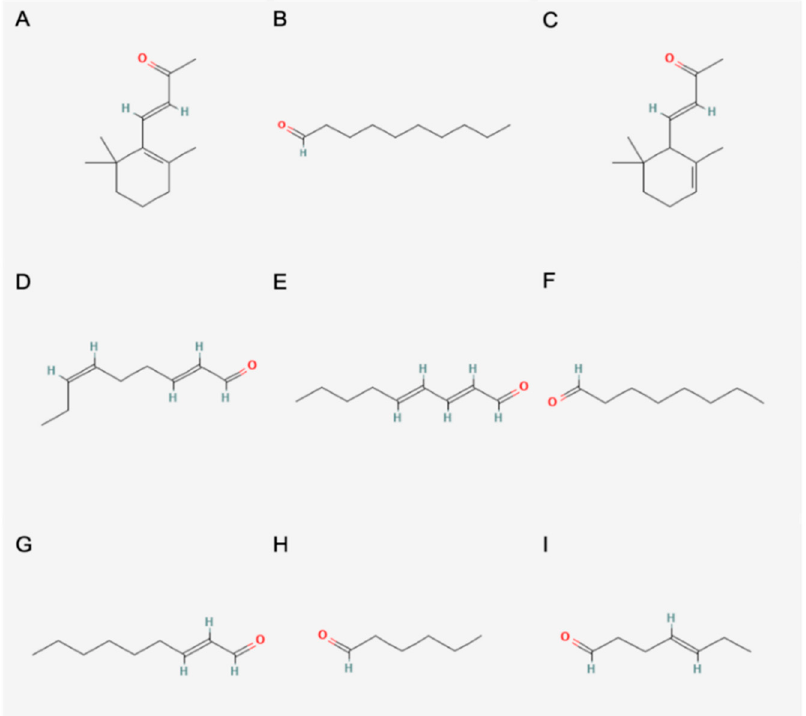
Figure 22. Structure of the main aroma compounds. ( A ): β -ionone, ( B ): decanal, ( C ): α -ionone, ( D ): ( E , Z )-2,6-nonadienal, ( E ): 2,4-nonadienal, ( F ): octanal, ( G ): ( E )-2 nonenal, ( H ): hexanal, ( I ): 4-heptenal [56].